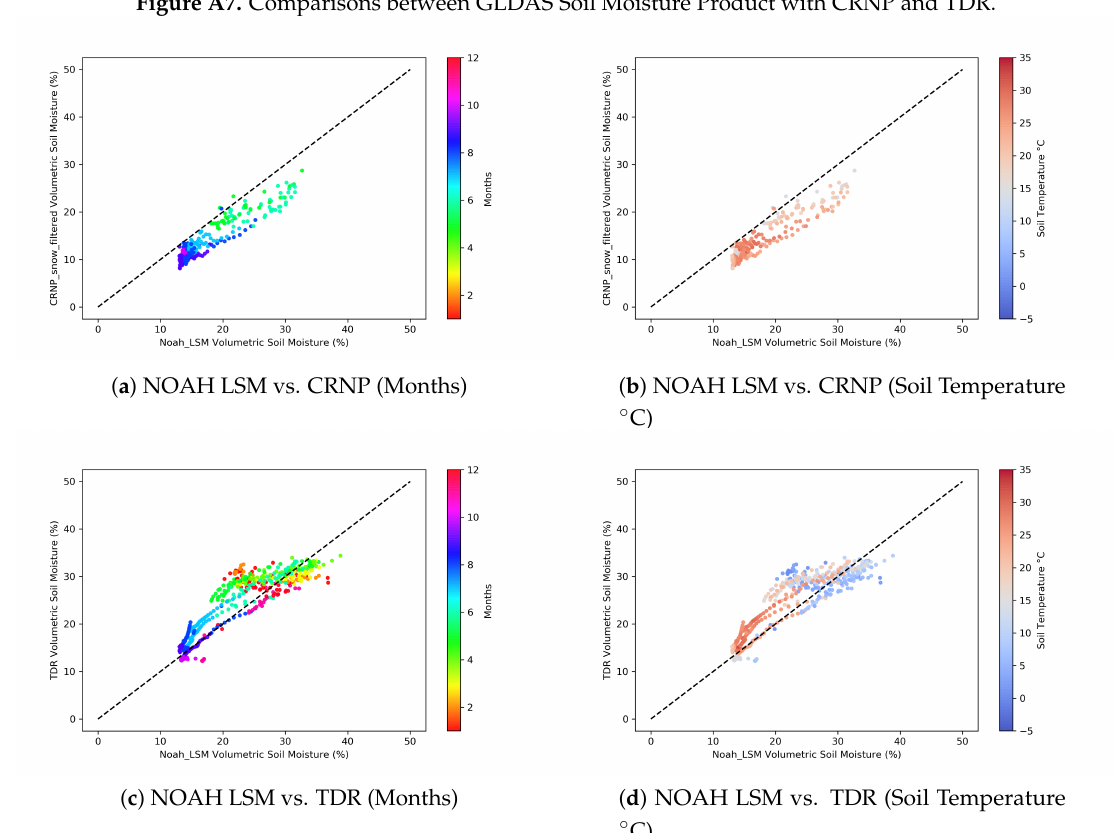
Figure A8. Comparisons between NOAH LSM Soil Moisture Product with CRNP and